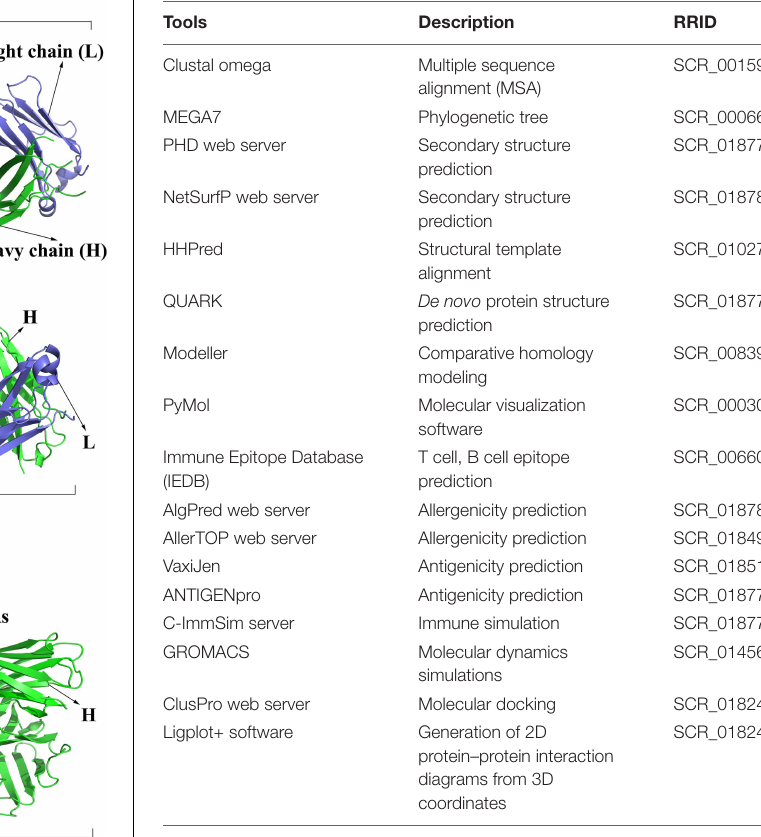
TABLE 3 | Bioinformatics tools in the